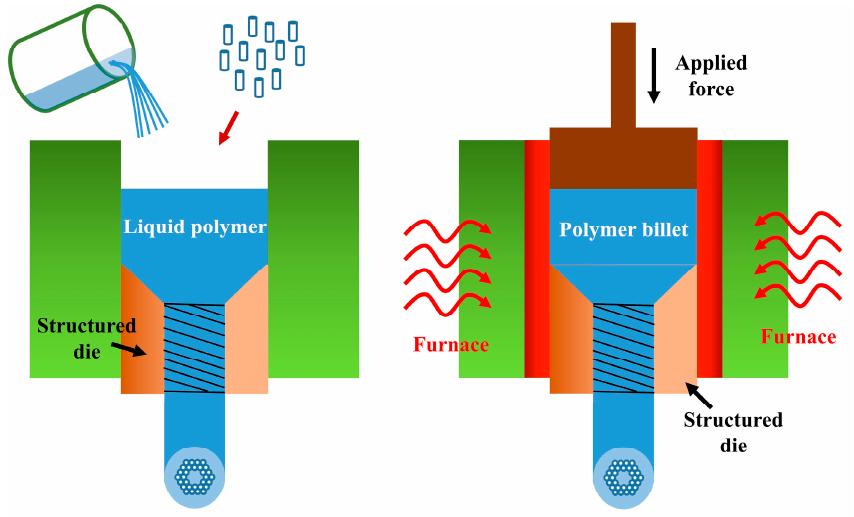
Figure 5. Schematic MPOFs preform fabrication using a liquid polymer extrusion and billet extrusion technique.